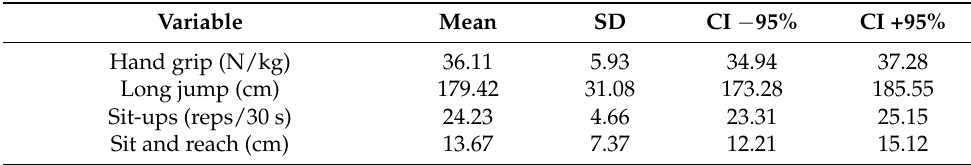
Table 1. Physical performance tests results.